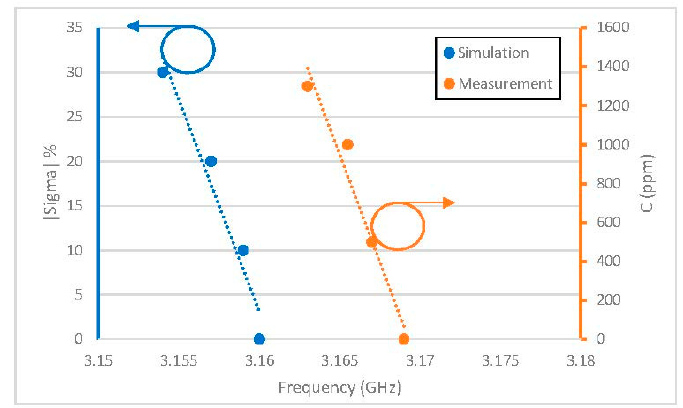
Figure 12. Comparison between measurement and simulation.